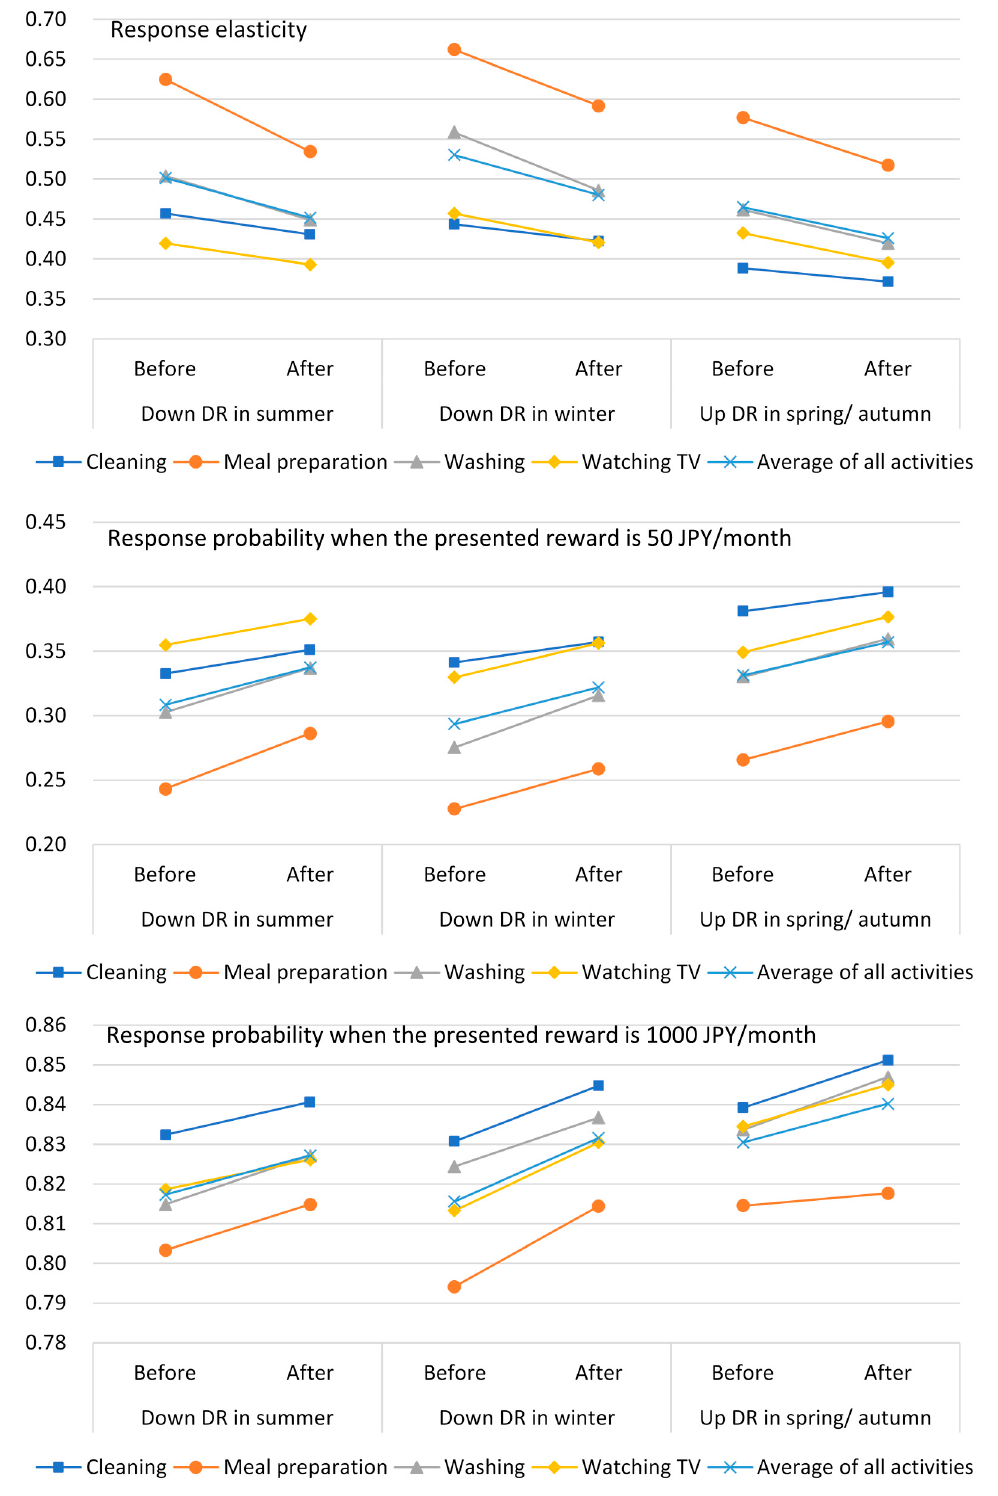
Figure 5. E ff ect of providing knowledge about DR e ff ectiveness on response probability (comparison Figure 5. Effect of providing knowledge about DR effectiveness on response probability (comparison before and after providing before and after providing knowledge).